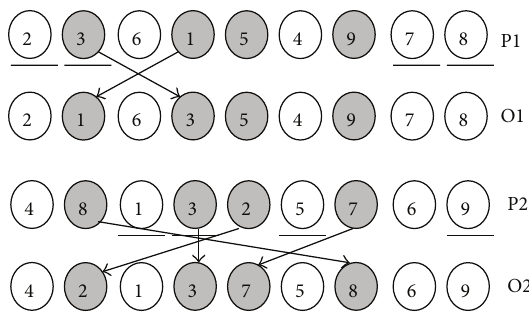
Figure 1: Position based crossover (PBC). Figure 2: Two-point crossover (TPC).